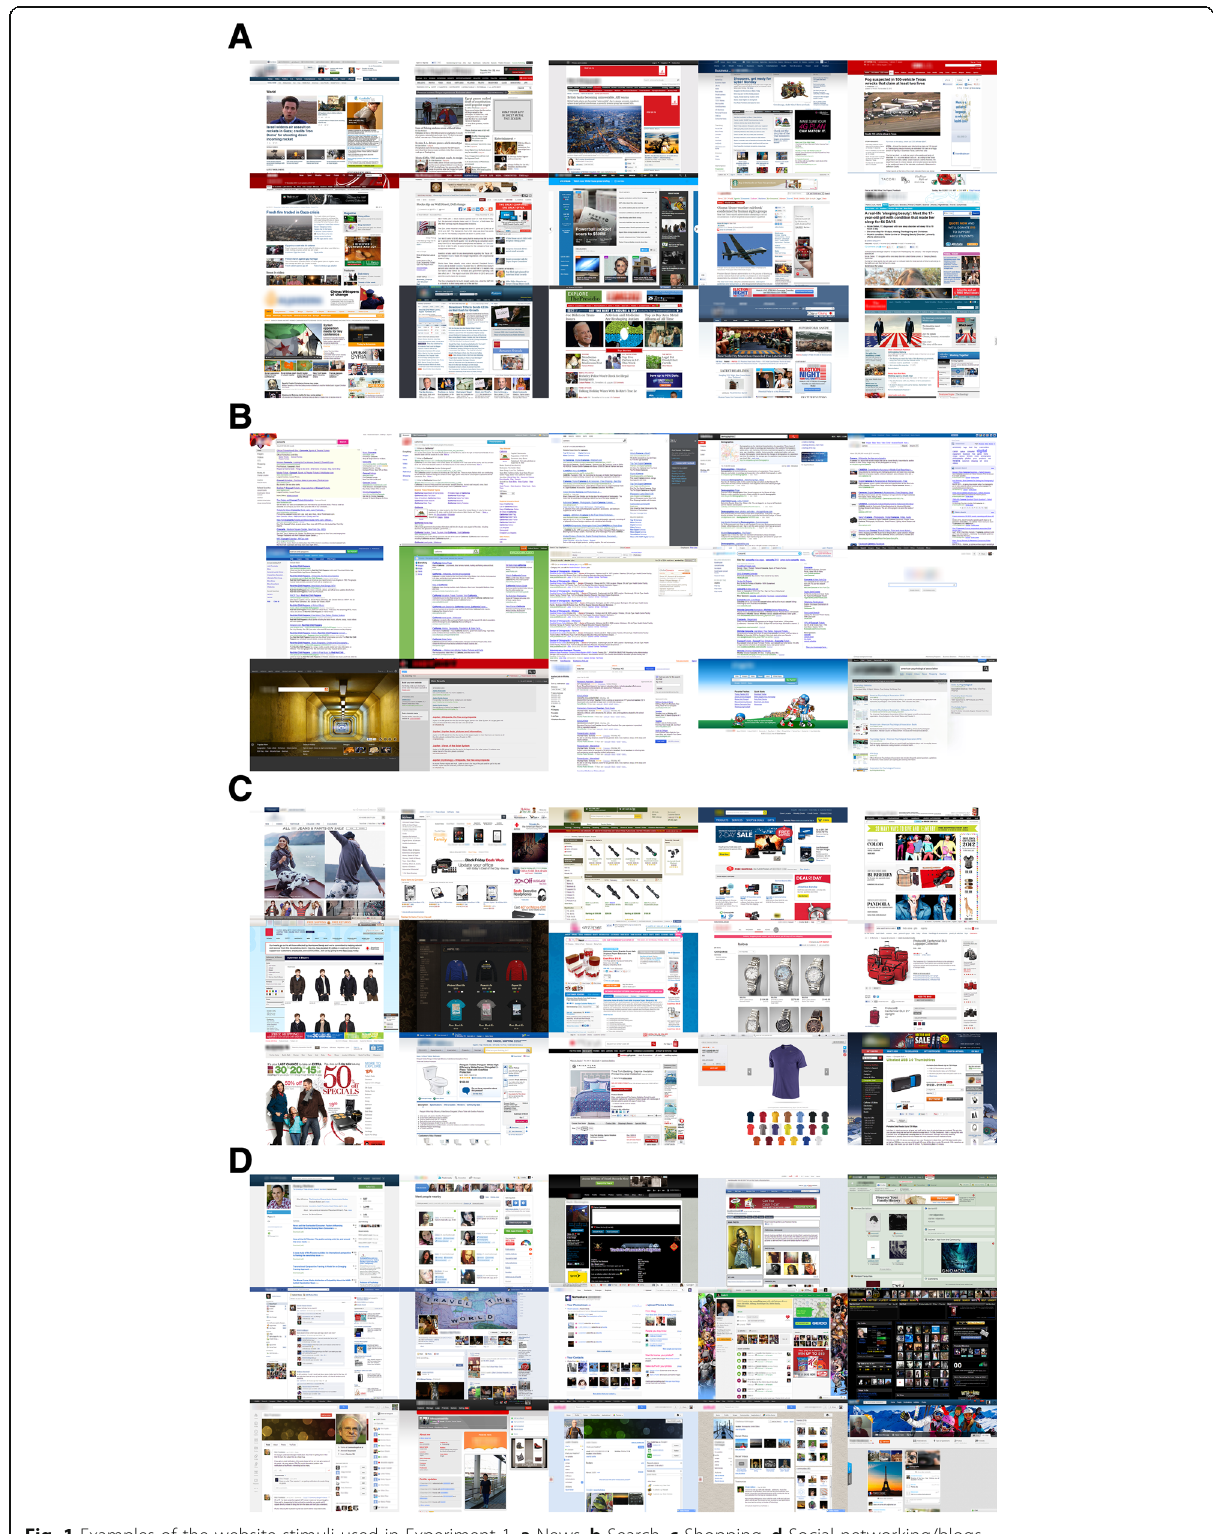
Fig. 1 Examples of the website stimuli used in Experiment 1. a News. b Search. c Shopping. d Social